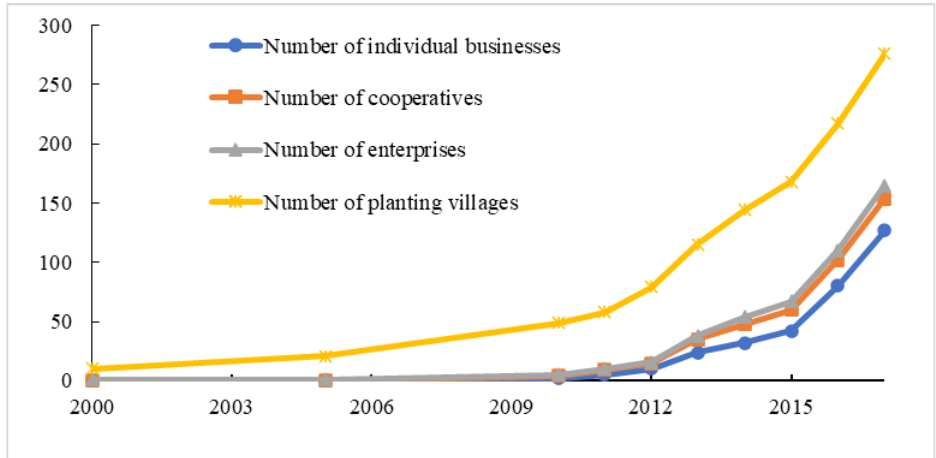
Figure 6. Numbers of different producers at different times.